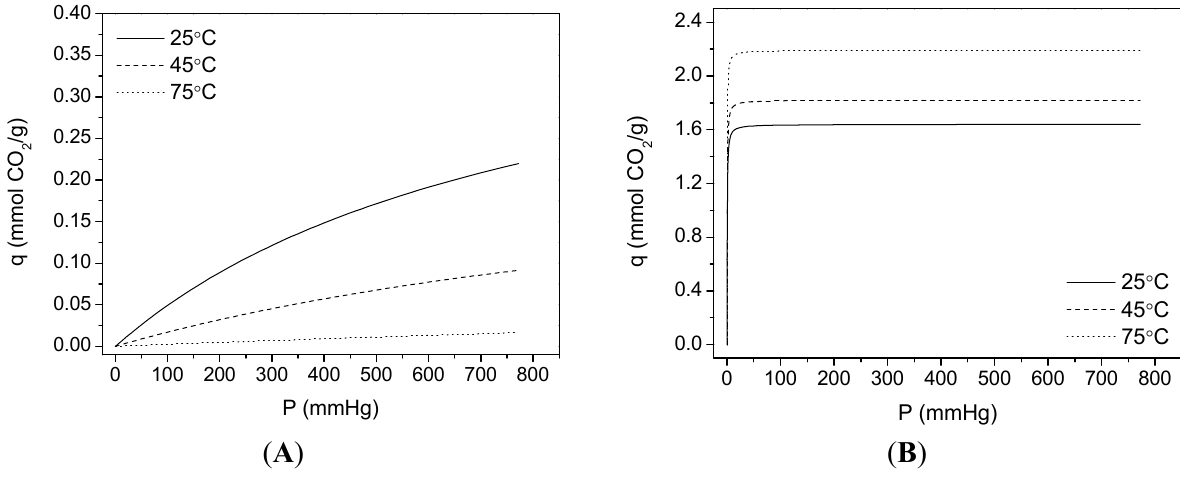
Figure 10. Deconvolution of CO 2 adsorption isotherms for TiPB-F/50PEI in their respective physisorption ( A ) and chemisorption ( B )